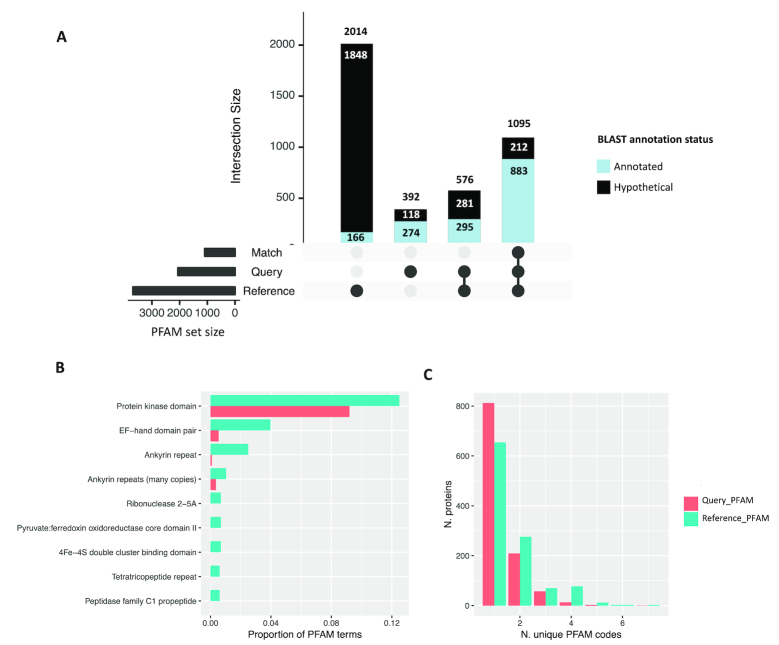
Structure prediction and homology searching elaborates putative functions for query peptides. (A) Intersection of predicted structures for which Pfam codes were available via query or reference peptides. The majority of structures predicted from BLAST-annotated peptides (blue vertical bars) had at least one Pfam annotation that matched with the reference structure. The majority of peptides that lacked BLAST annotation (aka “hypothetical proteins”; black vertical bars) also lacked Pfam codes. A total of 824 proteins (792 hypothetical) for which no Pfam codes were annotated in the query or the reference are not displayed. (B) Differential abundance of Pfam codes assigned to query and reference peptides for 1,095 high-confidence pairs. (C) Number of unique Pfam codes available for query (orange) and reference (teal) peptides for 1,095 high-confidence pairs. The right-shifted distribution in reference-derived Pfam codes indicates an overall increase in annotation via this method.